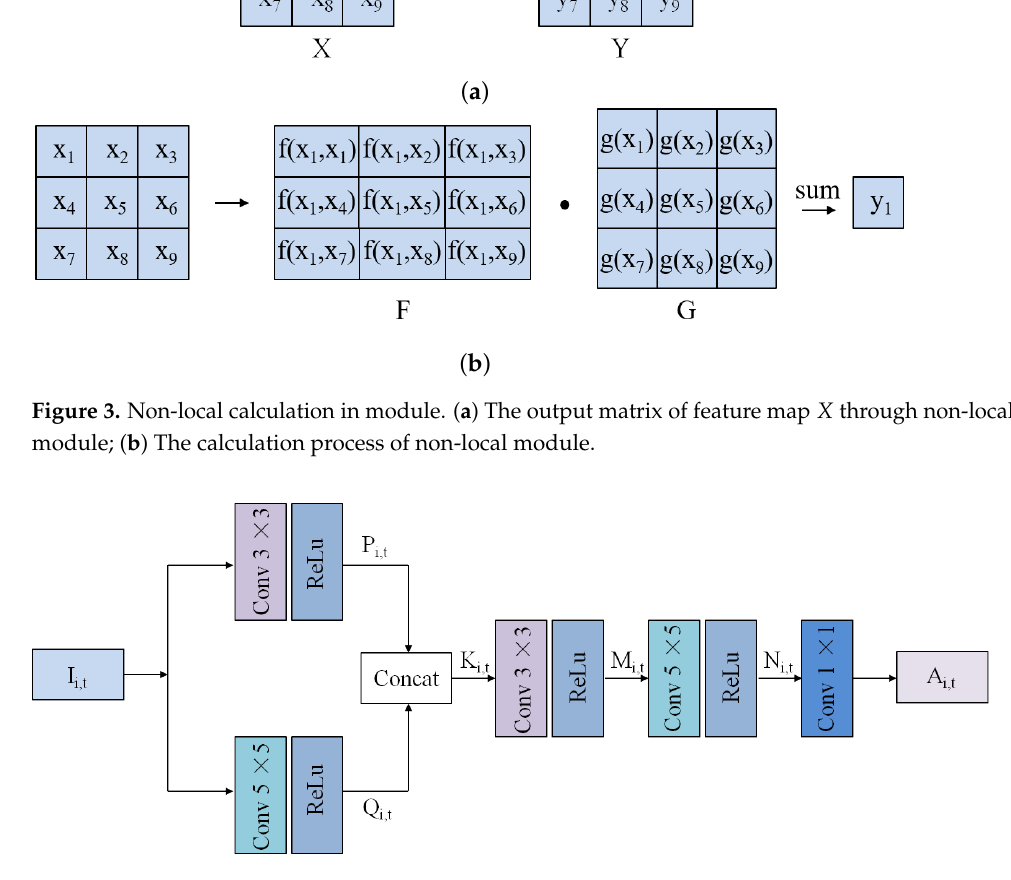
Figure 4. The structure of the proposed